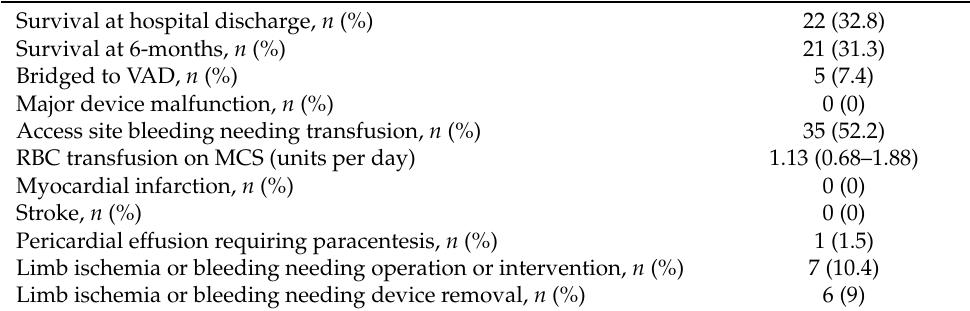
Table 4. Survival and safety